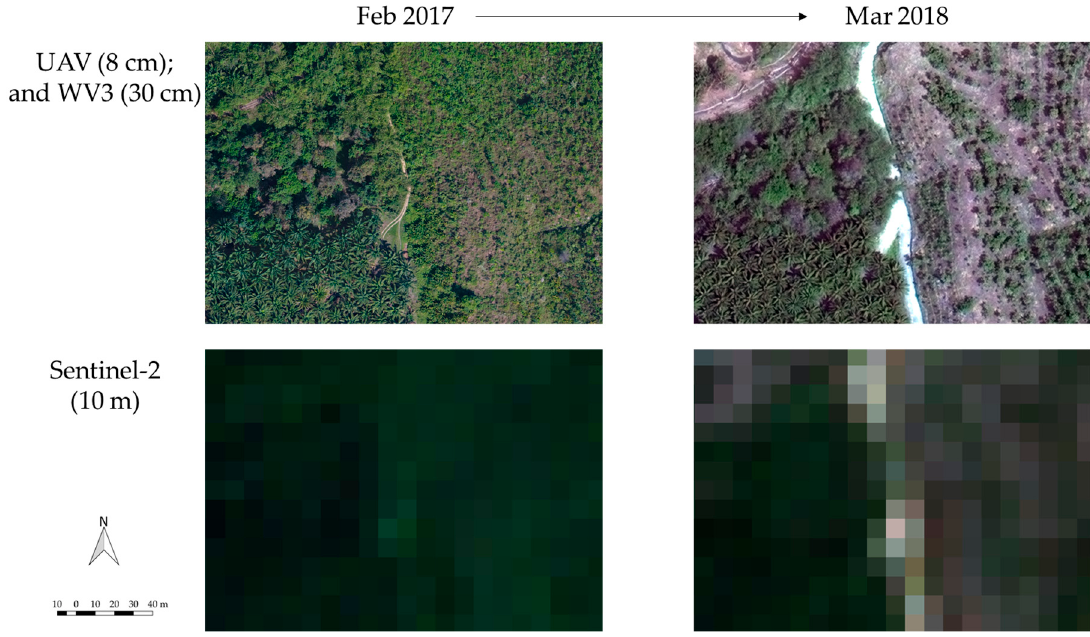
Figure 2. Examples of images of the same location using UAV, WV3, and Sentinel-2 in February 2017 and March 2018 (shown in RGB).